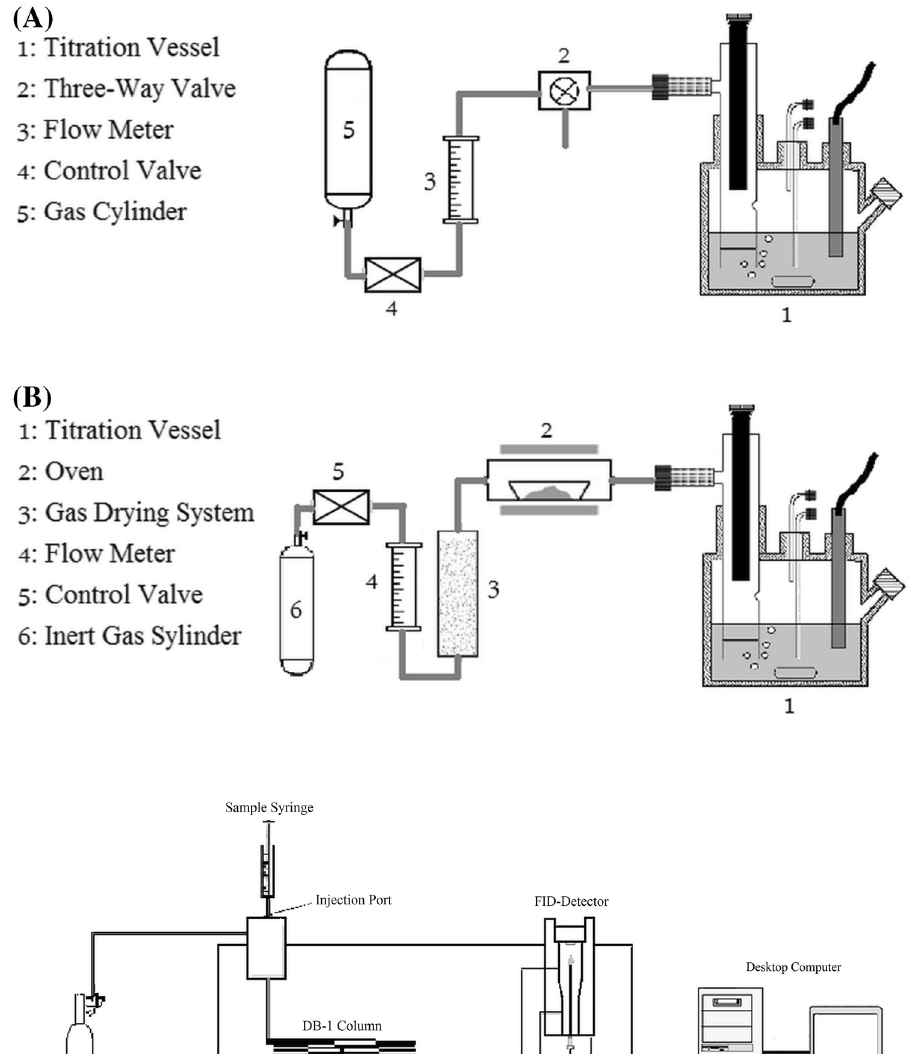
Fig. 5 Coulometric Karl Fischer setups for determining the amount of water in the gas ( a ) and condensate ( b ) outlets